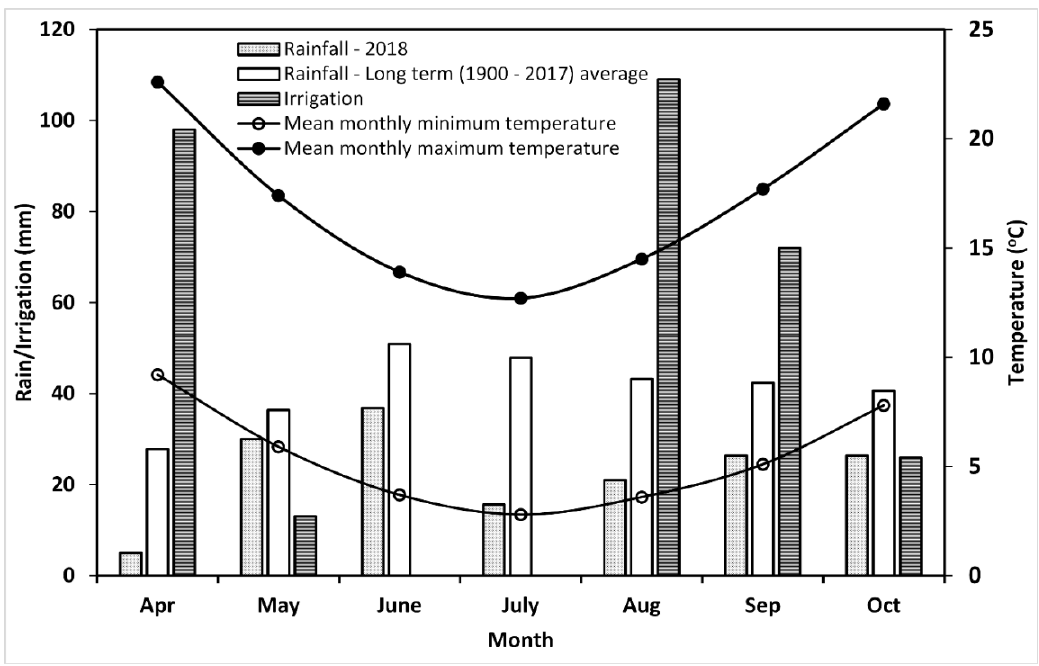
Figure 1. Long-term average rainfall and temperature and experimental season rainfall and irrigation at Wagga Wagga.